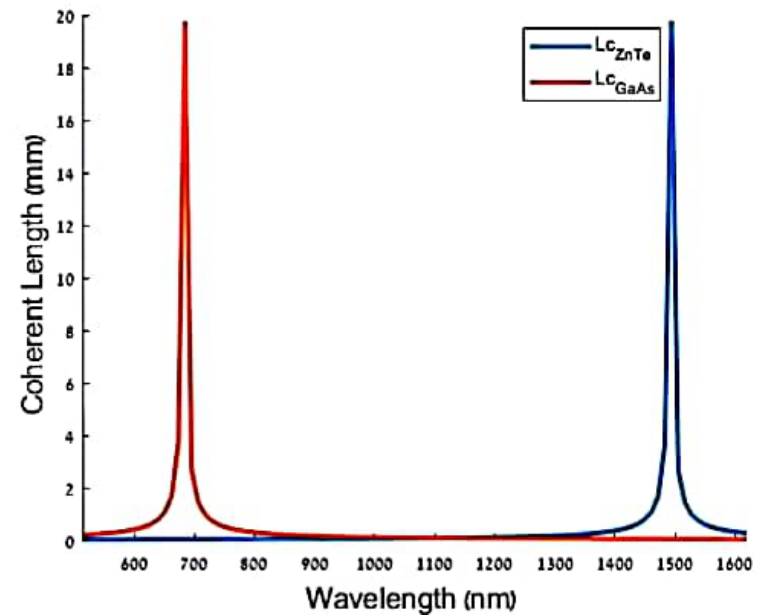
Figure 4. The coherence length for the GaAs and the ZnTe